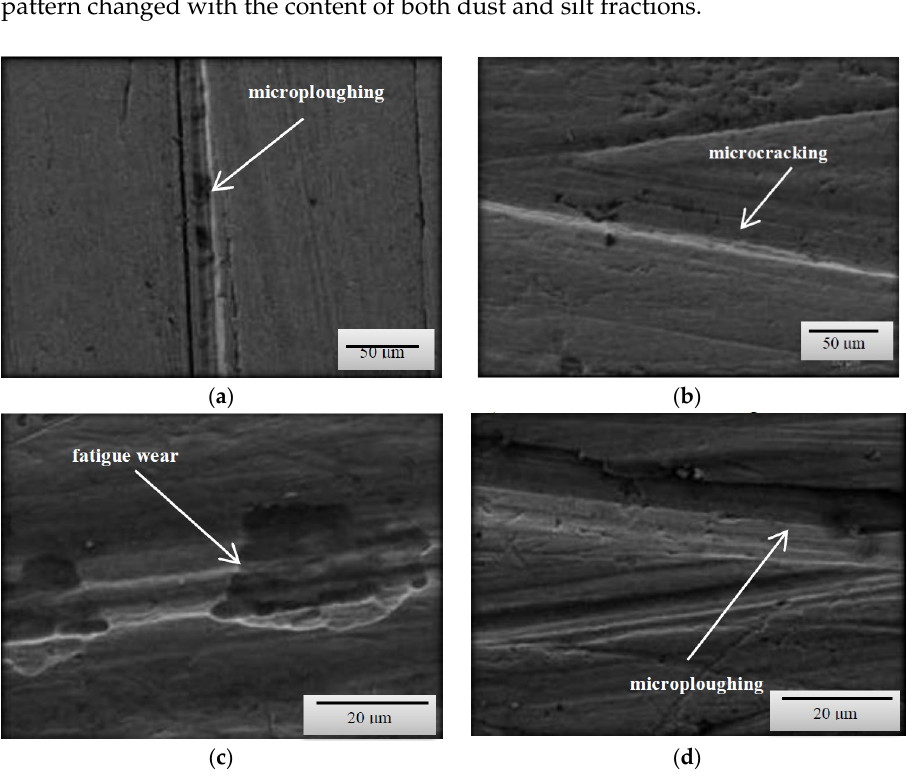
Figure 3. SEM micrographs of the surfaces of tested steels subjected to wear in a light soil ( a ) B27 steel, magnification 50×; ( b ) Hardox 500 steel, magnification 50×; ( c ) XAR 600 steel, magnification 500×; ( d ) TBL Plus steel, magnification 500×.